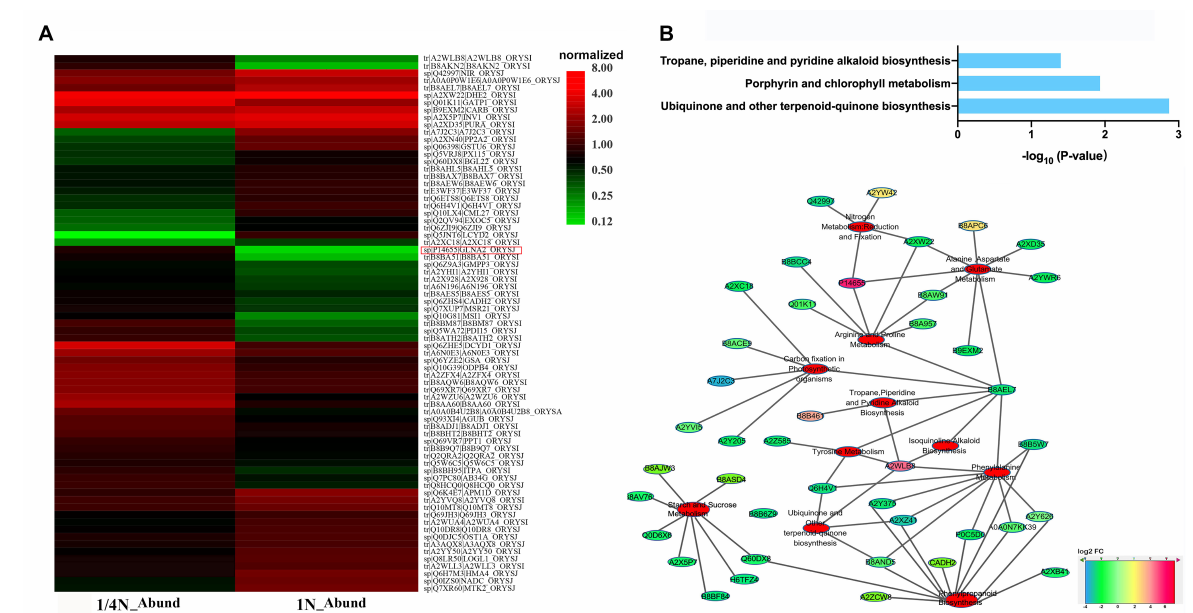
Figure 2. N-deficiency responses in proteome profiling in LY9348 roots. ( A ) Heat map analysis of candidate DAPs; ( B ) cluster of KEGG pathways and DAPs putatively related to candidate pathways. Networks were visualized by Cytoscape (3.2.0). DAPs: different abundance proteins; Abund: quantitative protein abundance value of sample; FC: fold